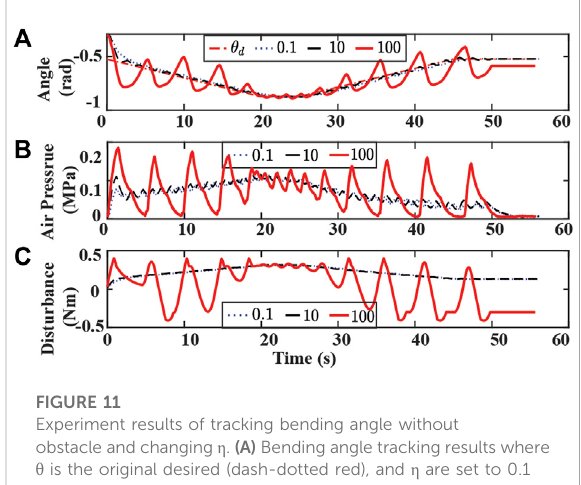
FIGURE 11 Experiment results of tracking bending angle without obstacle and changing η . (A) Bending angle tracking results where θ is the original desired (dash-dotted red), and η are set to 0.1 (dotted blue), 10 (dashed black), 100 (solid red), respectively. (B) Air pressure measurements of chamber 1. (C) Lumped disturbance estimation.